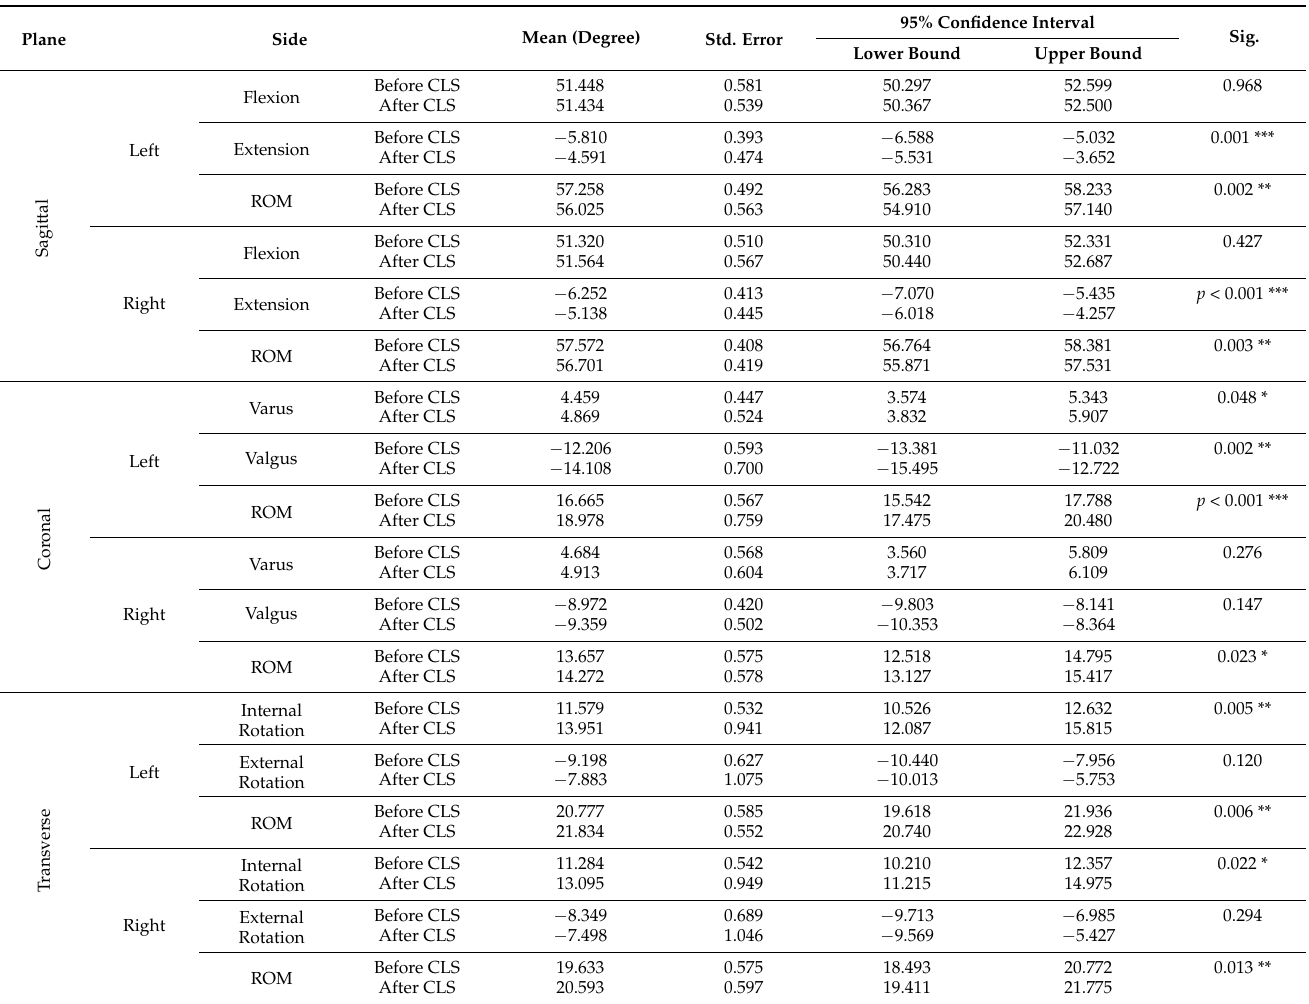
Table 4. Knee Joint Angle in sagittal, coronal, and transverse